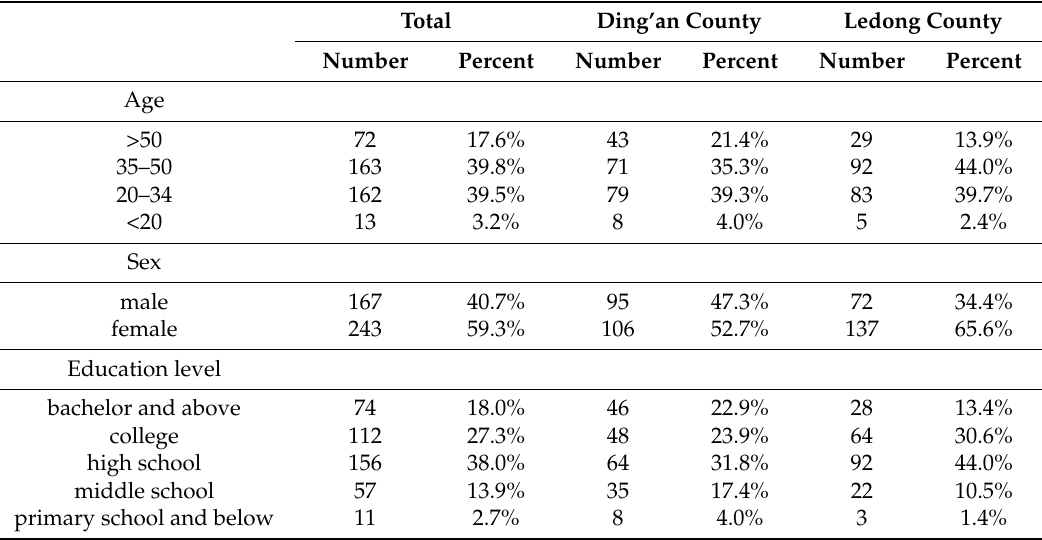
Table 2. Demographic composition of the